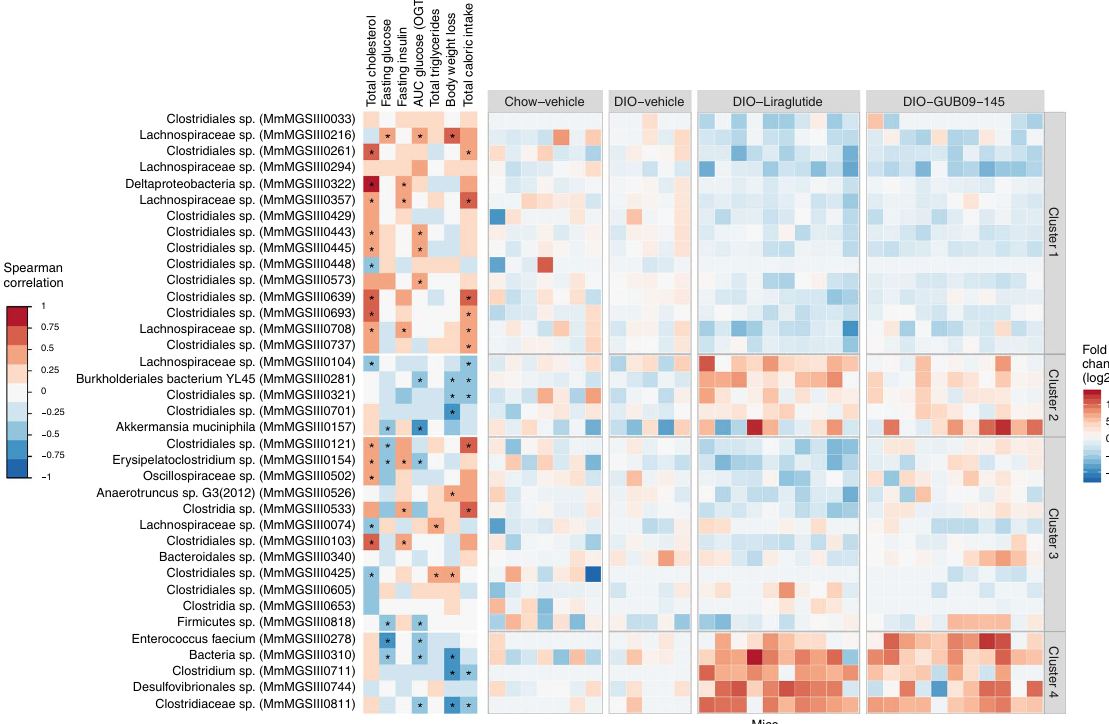
Figure 5. Correlation of metagenomic species abundance to changes in metabolic parameters. Overview of metagenomic species significantly changing in abundance over the course of liraglutide and GUB09-145 treatment. Hierarchical clustering analysis yielded four individual species categories: ( Cluster 1 ) species with reduced abundance after liraglutide or GUB09-145 treatment; ( Cluster 2 ) species with increased abundance primarily after liraglutide treatment; ( Cluster 3 ) species with abundance change specific to one drug treatment group only; ( Cluster 4 ) species with increased abundance after both liraglutide and GUB09-145 treatment, and no differences between the two vehicle groups. Left heatmap : Spearman correlations between change in individual species abundance and various metabolic parameters affected by treatment, including plasma total cholesterol (TC), fasting glucose level on treatment day 14 (Fasting glucose), fasting terminal insulin levels (fasting insulin), glucose area-under the curve in an oral glucose tolerance test on treatment day 27 (AUC glucose OGTT), terminal plasma total triglycerides (TG), endpoint body weight loss relative to baseline (Body weight loss), and total energy intake during the treatment period (Total caloric intake). Asterisks denote significant correlation (FDR-corrected, p < 0.05) between individual species and relevant metabolic parameter. Right heatmap : Fold change (log 2 transformed) in species abundance in individual mice as compared to